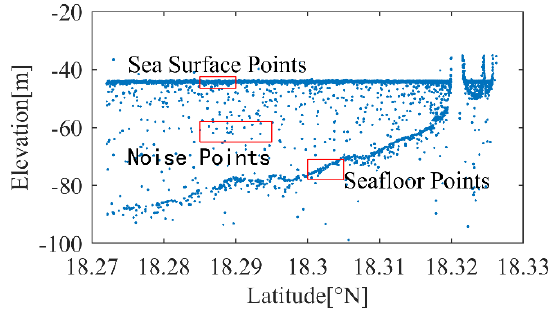
Figure 4. ATL03 photon point cloud cross − section.